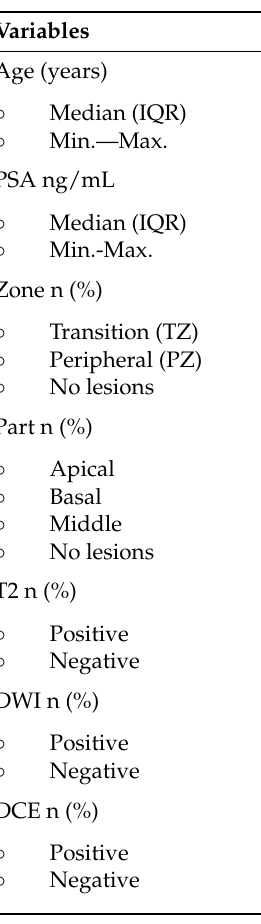
Table 1. Clinical characteristics of the